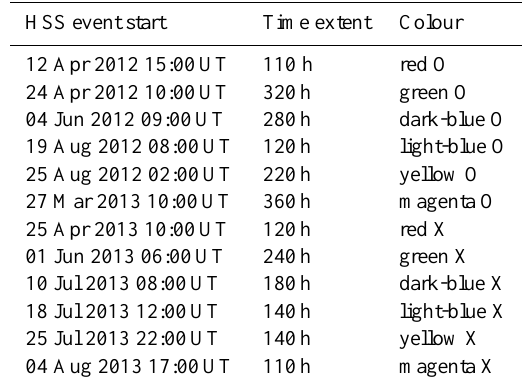
Table 2. Dates and times of onset for HSS events used in Figs. 5, 9, 10 and 11. The number of hours after HSS onset which have been used in the analysis is given in the second column. The third column shows the corresponding line colour and symbol used in Fig. 5.